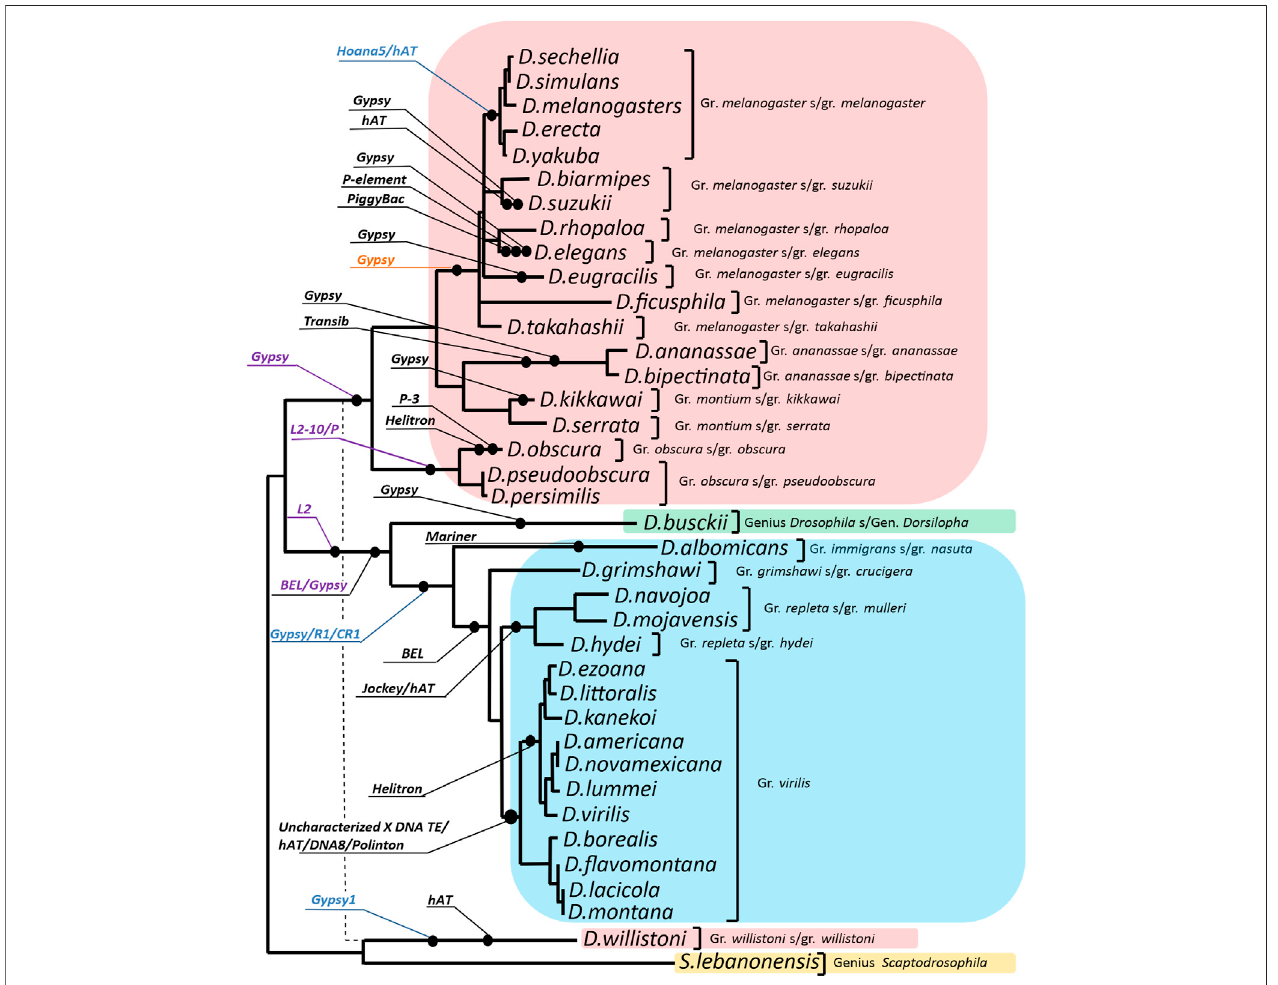
FIGURE 2 | Distribution of the identi fi ed transposon insertion events on the evolutionary tree of the analyzed Drosophila species. The phylogenetic tree was constructedusingtheMaximumLikelihoodmethodonthebaseoftheTamura3-parametermodel.Sequencesofexonsand3 ′ UTRofthe ras85D geneof37 Drosophila species were used. Gamma distribution was used to model evolutionary rate differences among sites [5 categories (+G, parameter (cid:1) 0.8107)]. The rate variation model allowed some sites to be evolutionarily invariable [(+I), 19.28% sites]. The structure of the resulting phylogenetic tree is generally consistent with the species tree obtainedfor155genomesof Drosophila species(Suvorovetal.,2021)excluding D.willistoni ,forwhichthepositiononthespeciestreeisindicatedbyadashed line.The callouts specifythe transposable element and insertion events on the branches of the evolutionary tree. Callout-designated insertions in the following regions: intergenic region, promoter, 5 ′ UTR, and intron 1, were highlighted in black, blue, purple, and orange, respectively.